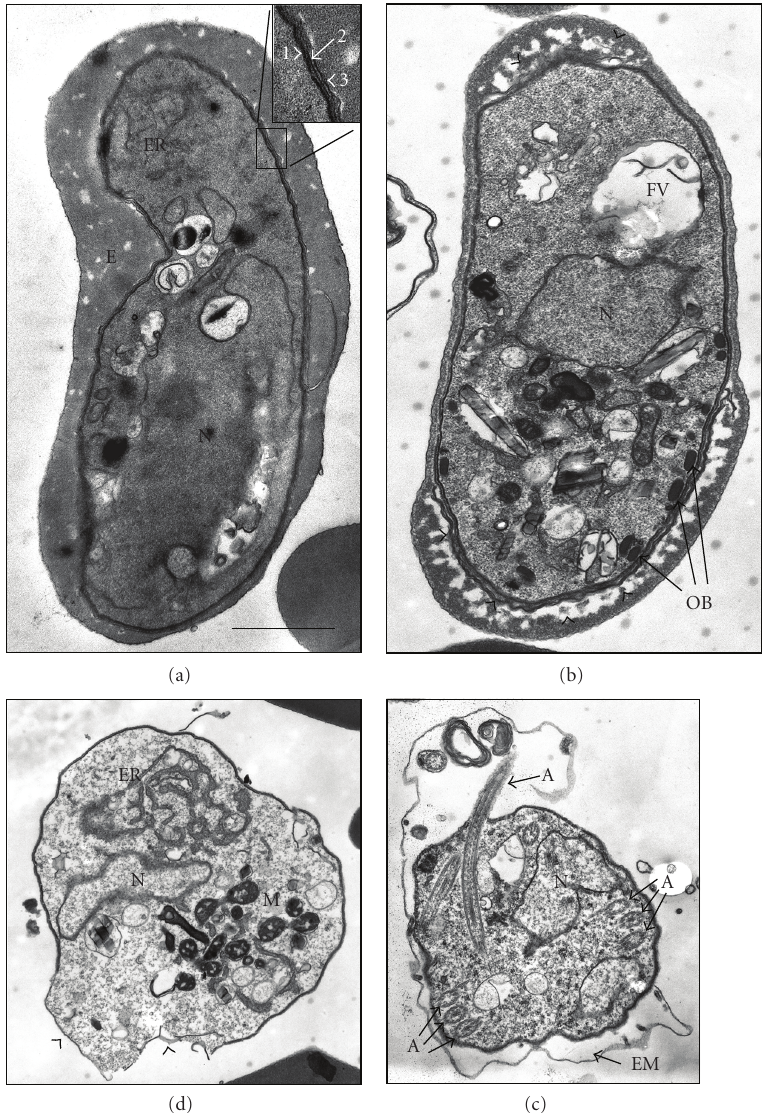
Figure 1: Ultrastructural changes in P. falciparum gametocytes during activation. (a) Transmission electron micrograph of a mature, non- activated gametocyte. The erythrocyte is reduced to an electron-light hem. The PVM is located adjacent to the PPM and the PV is therefore not discernable. No osmiophilic bodies are detectable, indicating that a male microgametocyte is pictured. Inset shows the pellicular membrane complex, depicting the SPM (1), the PPM (2) and the PVM (3). (b) A female macrogametocyte two-minute postactivation. The gametocyte is in the process of rounding up, thereby loosing its crescent shape. The osmiophilic bodies become closely associated to the parasite surface. At the poles, the PVM separates from the PPM and the erythrocyte is in the process of degrading (arrowheads). (c) Ultrastructure of an exflagellating microgametocyte. The axoneme of a forming microgamete is visible as longitudinal section, and several other cross sections of axonemes are detectable inside the microgametocyte. The PVM has disappeared and the EM ruptured. (d) A female macrogamete after emergence. This stage is marked by pronounced ER and the highly branched single mitochondrion. The SPM is in the process of disintegrating (arrowheads). A, axoneme; EM, erythrocyte membrane; ER, endoplasmic reticulum; FV, food vacuole; M, mitochondrion; N, nucleus; OB, osmiophilic body; PPM, parasite plasma membrane; PV, parasitophorous vacuole; PVM, PV membrane; SPM, subpellicular membrane. Bar, 1 μ